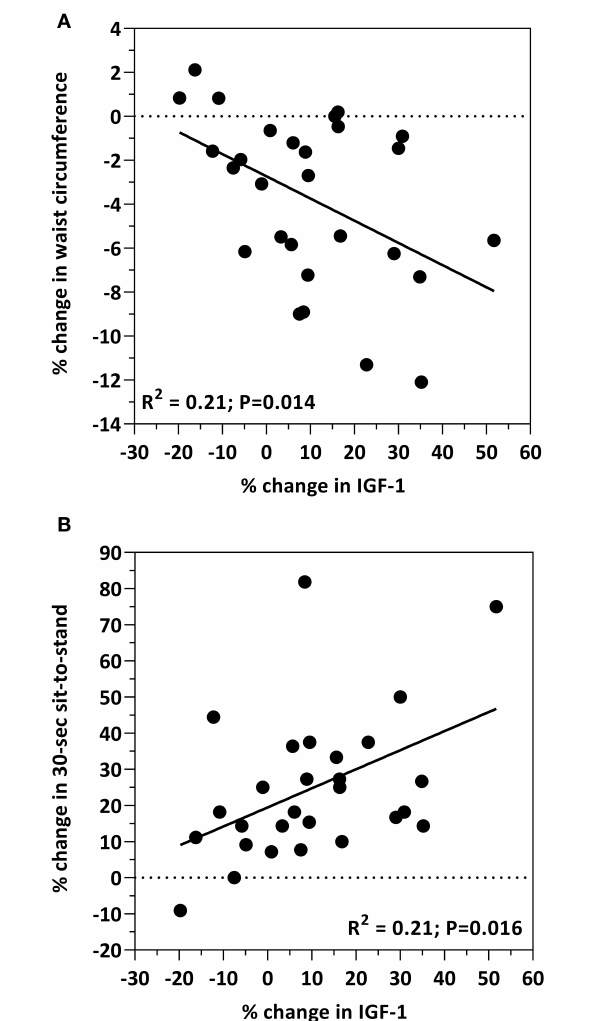
FIGURE 2 | Bivariate correlations between the percent change from baseline in IGF-1 levels and the percent change from baseline in waist circumference (A) and the 30-s sit-to-stand test (B) .